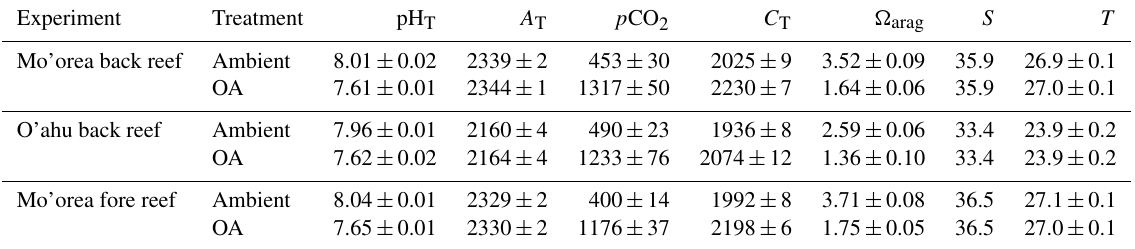
Table 1. Mean carbonate chemistry and temperature treatments in the flumes during the experiments conducted with back reef communities in Mo’orea and O’ahu, and the fore reef community in Mo’orea. The mean ± SE partial pressure of CO 2 ( p CO 2 ) and the saturation states of aragonite ( (cid:127) arag ) were calculated from pH T , total alkalinity ( A T ), salinity ( S ), and temperature ( T ). SE for salinity was < 0.1. Experiment Treatment pH T A T p CO 2 C T (cid:127) arag S T Mo’orea back reef Ambient 8.01 ± 0.02 O’ahu back reef Mo’orea fore reef